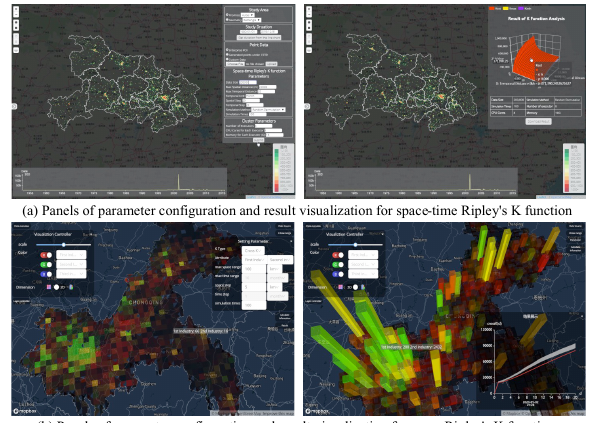
Figure 14. Graphical user interfaces (GUIs) of the Web-based visual analytics